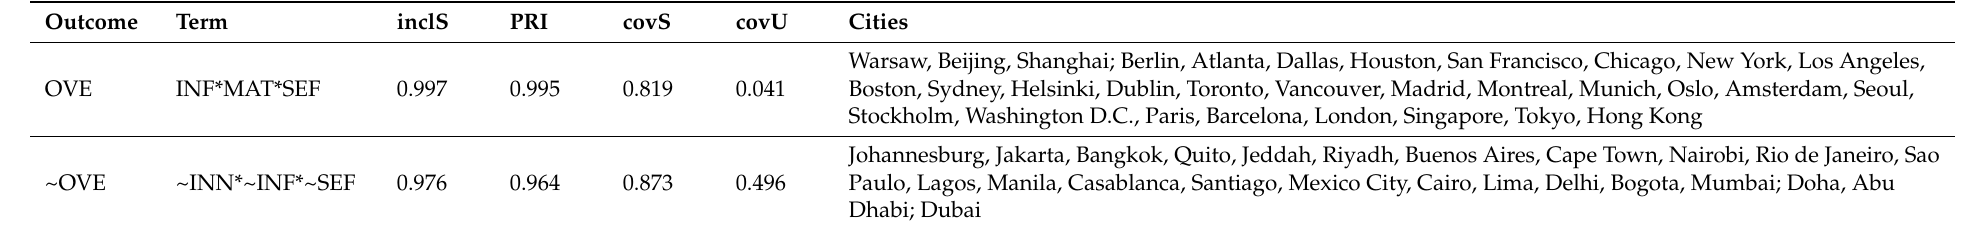
Table 1. Selected terms for each solution.